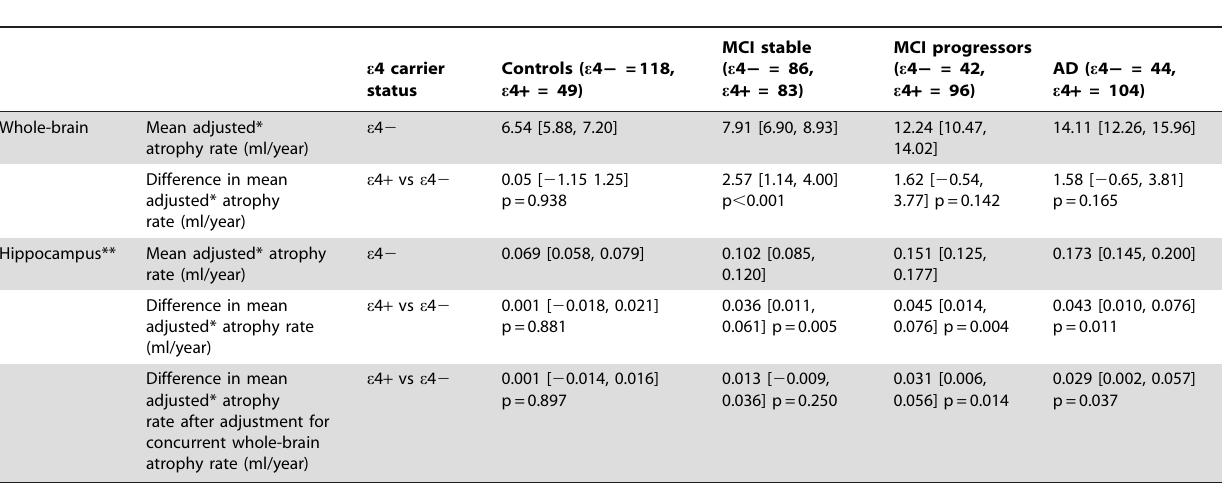
* all values are for a 50/50 gender split and are adjusted for disease-group specific mean age, baseline brain-to-total intracranial volume ratio, MMSE score, and total intracranial volume. **average of left and right.